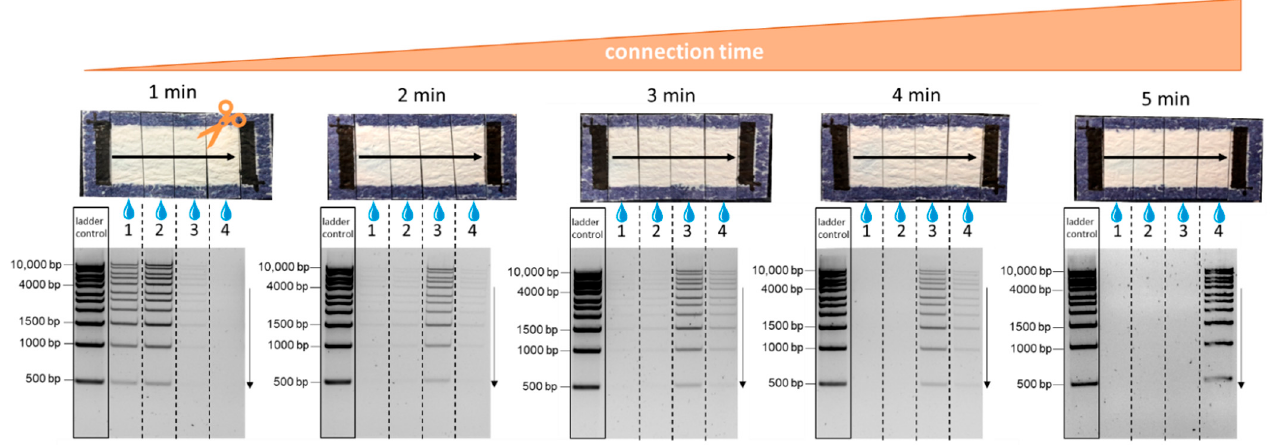
Figure 6. Fiber-based electrophoresis chips with printed electrodes after different connection times to the voltage source using meas- urement setup 2. A 1 kb ladder was used as a sample to investigate the migration of the DNA fragments of different sizes. From left to right, the individual chips were used for electrophoresis at 45 V for 1, 2, 3, 4, and 5